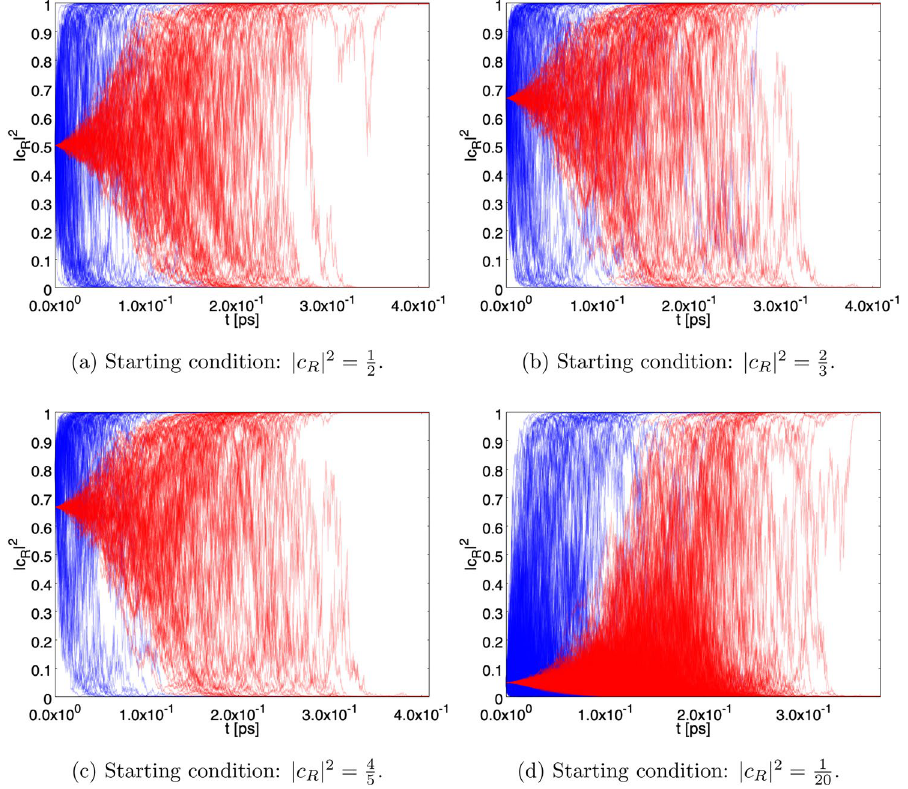
2 ) as function c R | |